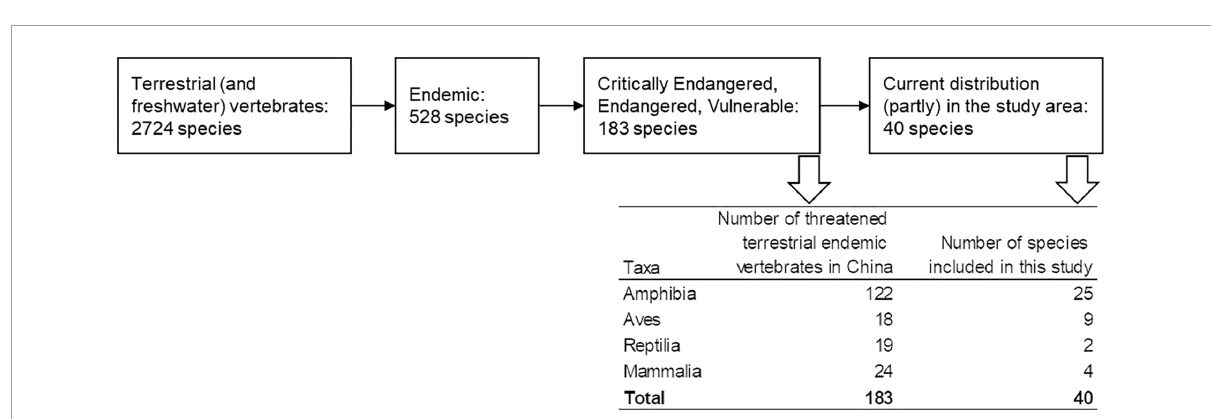
FIGURE2 Selection process and the number of studied species. Selection based on type and conservation status was done using information from the IUCN; overlap with the study area was checked either via online available occurrence data, published maps, or the IUCN published range.